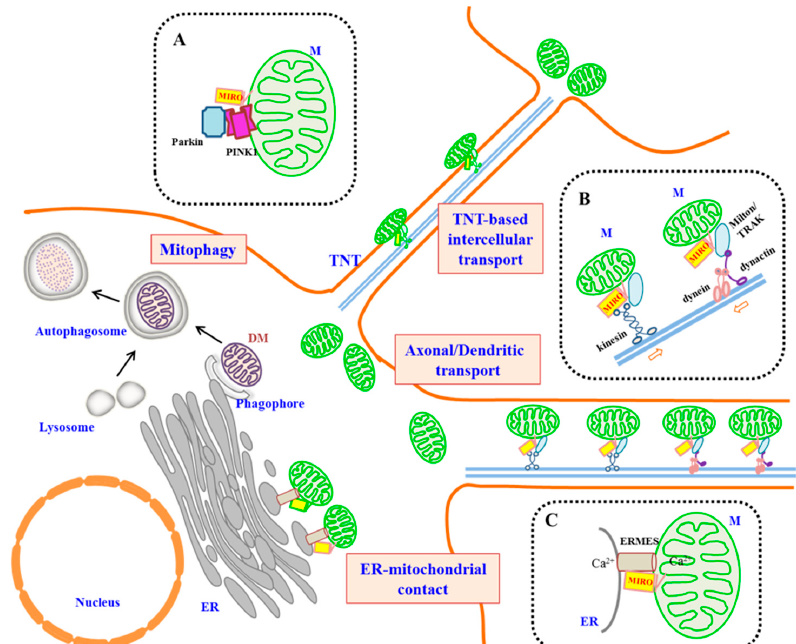
Figure 1. A schematic diagram illustrating the roles of MIRO in metazoans. A generalized cell is shown. Long-distance microtubule-based transport of mitochondria could occur intracellularly (such as in processes of neurons and astrocytes), as well as intercellularly through tunneling nanotubes (TNTs) (not drawn to proportion). Insets (dotted-line boxes) highlight interacting partners of MIRO in three different functional contexts. ( A ) MIRO is the substrate of PINK-1 and Parkin and could be targeted for proteasomal degradation by these proteins. This attenuates mitochondrial mobility and may be a prelude to the mitophagy of damaged mitochondria (DM). ( B ) MIRO complexes with Milton/TRAK and kinesin to mediate anterograde axonal transport of mitochondria, as well as with dynein/dynactin for retrograde transport in axonal and dendritic transport. ( C ) MIRO has been shown to be part of the ER-mitochondrial encounter structure (ERMES) found at ER-mitochondrial contact sites and may have a speculated role in regulating Ca 2+ exchange. A family of Armadillo (Arm) repeat-containing proteins (encoded by the Armcx gene cluster in the X-chromosome that is unique to the Eutheria clade of mammals) was shown by Soriano and colleagues to be localized to the mitochondria [29]. One of these, Alex3/Armcx3, interacts with the